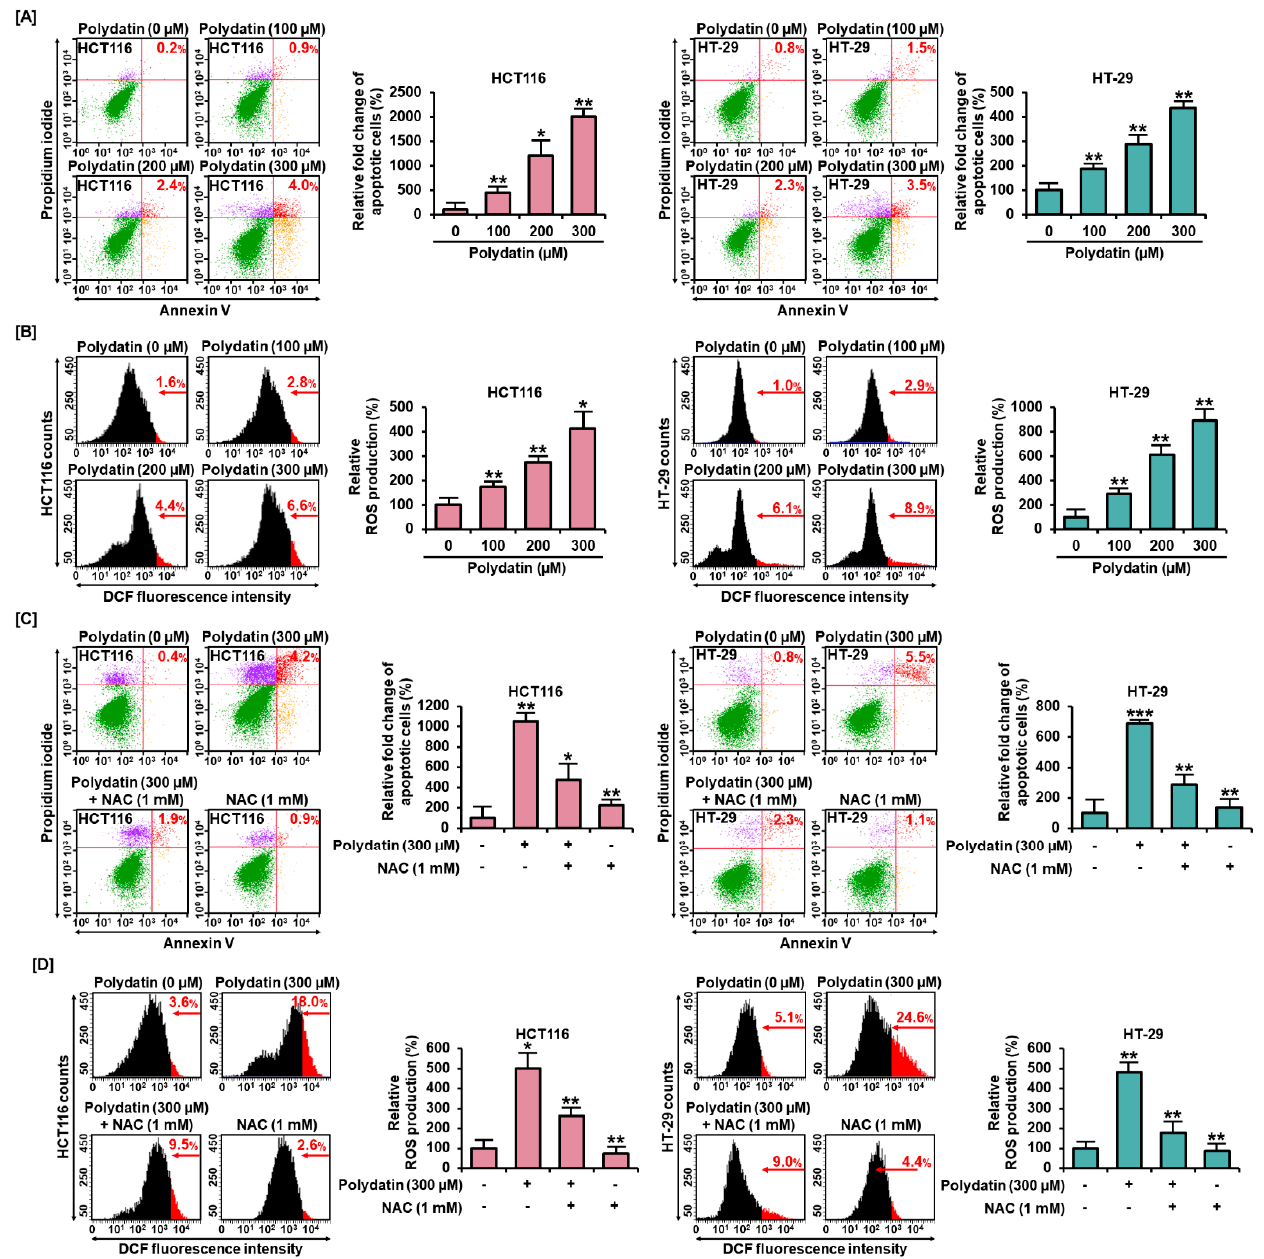
Figure 2. ROS production and apoptosis in response to polydatin in HCT116 and HT-29. ( A ) Apoptotic HCT116 and HT-29 treated with polydatin were evaluated using Annexin V and PI dyes. The red in the dot plot indicates late apoptotic cells. ( B ) ROS generation was determined using dichlorofluorescin (DCF) fluorescent dye by flow cytometry. ( C ) With or without ROS scavenger, the apoptotic cells induced by polydatin were stained using Annexin V and PI dyes. ( D ) The effects of polydatin ROS generation with or without NAC in HCT116 and HT-29 cells were analyzed by flow cytometry. The asterisks indicate statistical significance of the effect of treatment (* p < 0.05, ** p < 0.01, and *** p < 0.001).